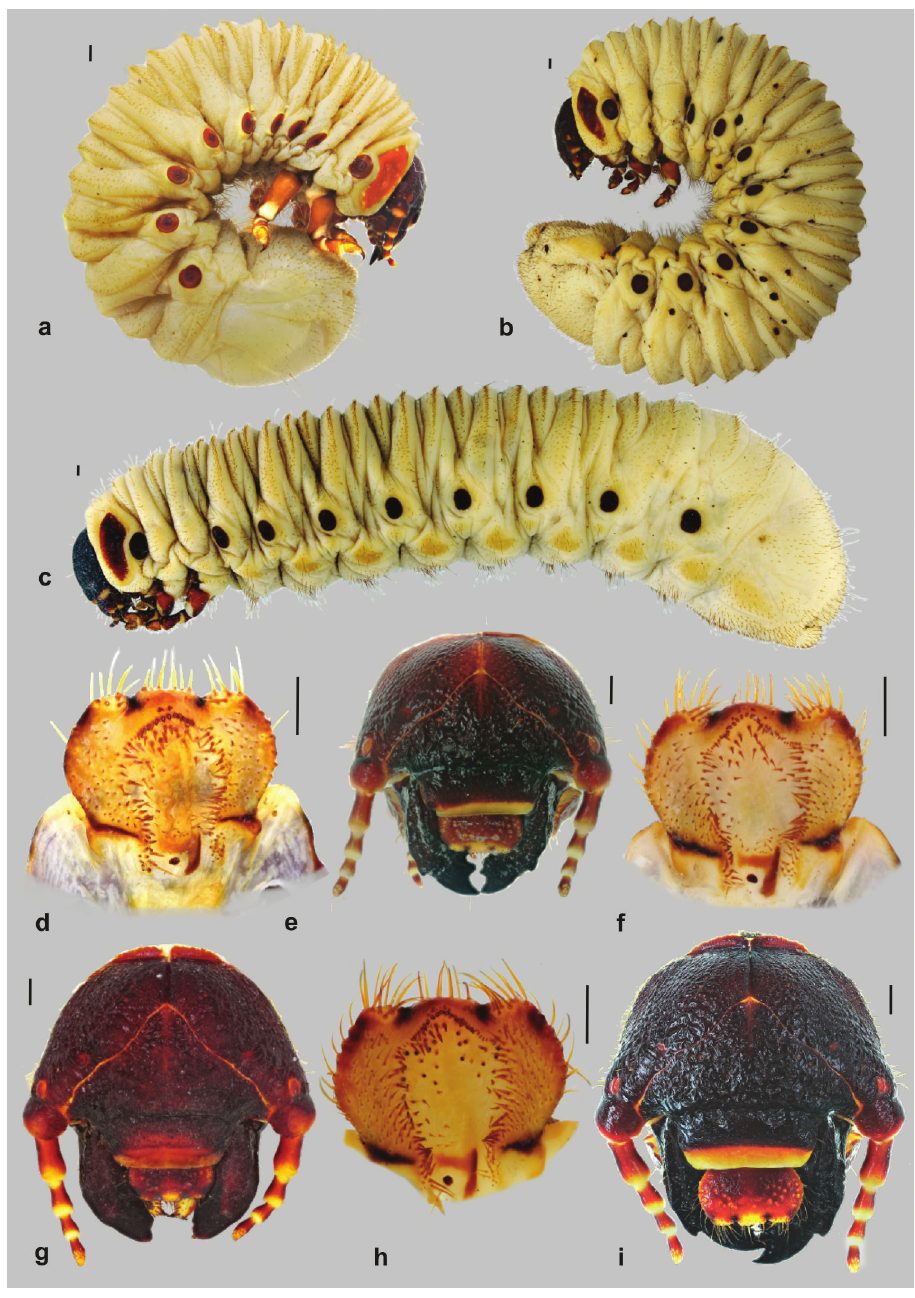
Figure 1. Immature stages of the genus Goliathus : A–C habitus ( A G. albosignatus B G. goliatu s C G. orientalis ) D, F, H epipharynx ( D G. albosignatus F G. goliatus H G. orientalis ) E, G, I cranium ( E G. albosignatus G G. goliatus I G. orientalis ). Scale bars: 1